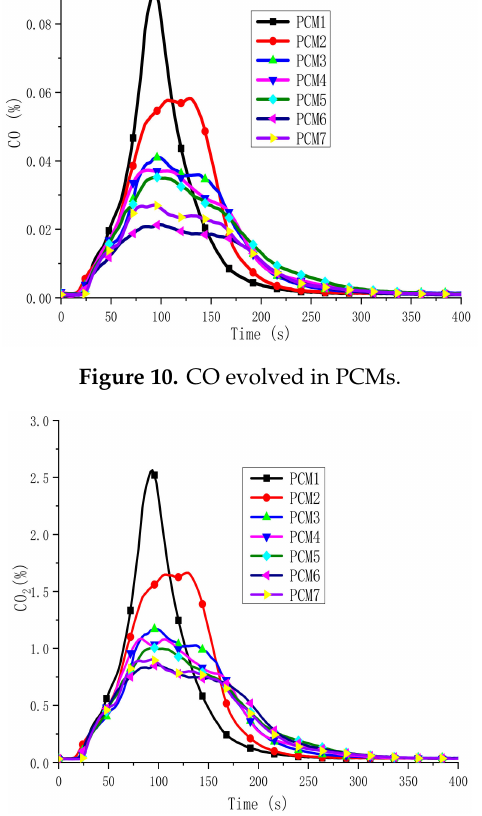
Figure 11. CO 2 evolved in